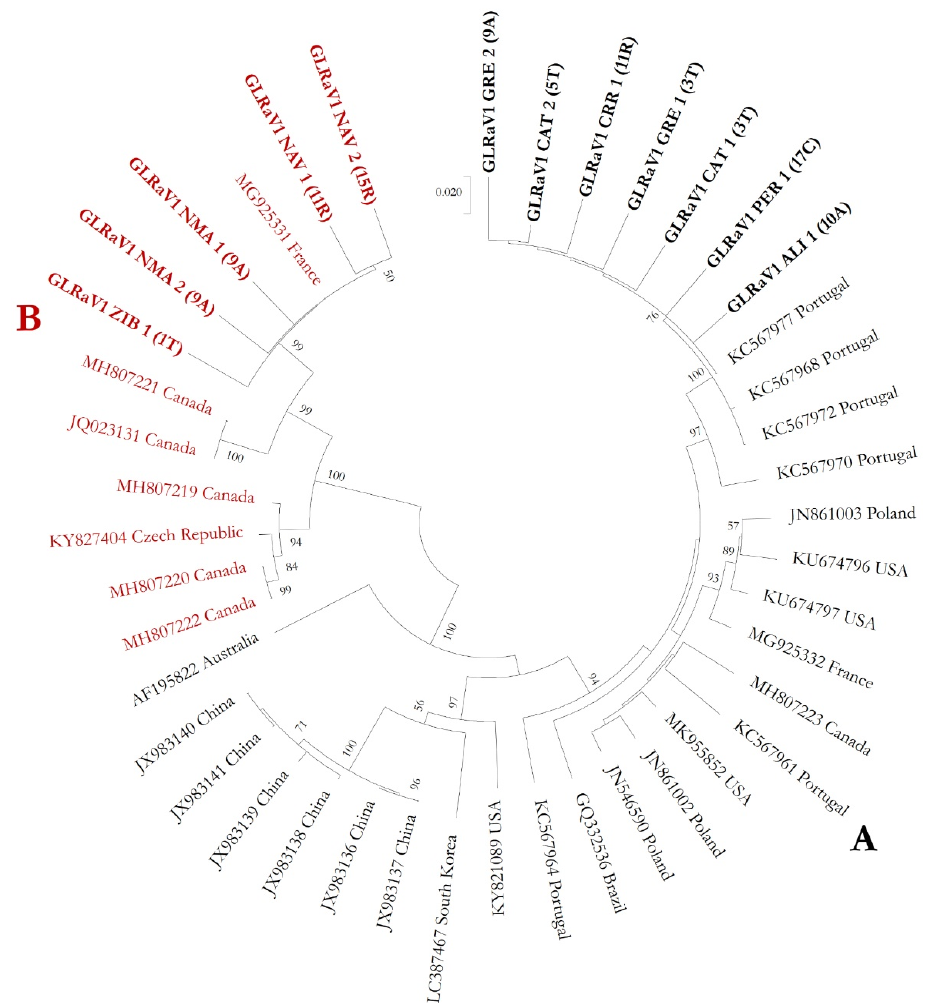
Figure 1. Phylogenetic relatedness between 12 Sicilian GLRaV-1 isolates and reference isolates retrieved from NCBI, based on coat protein gene. The evolutionary history was inferred by the maximum-likelihood method (ML) using the Kimura 2-parameter model (K2) (1000 replication bootstraps), conducted with the MEGA X program. Bootstrap values ≥ 50% are shown in the nodes. The sequences obtained in the present work are in bold. In brackets, the vineyard ID of origin (reported in Table 5). Black: cluster ( A ); red: cluster ( B